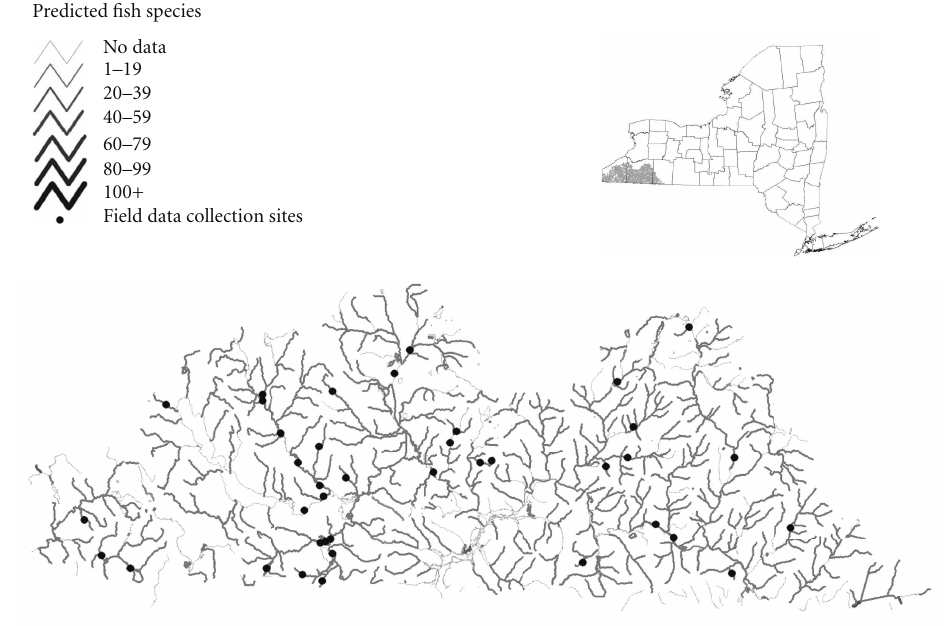
Figure 3: Predicted number of fish species and field data collection sites (black dots) in the upper Allegheny River basin in western New York.